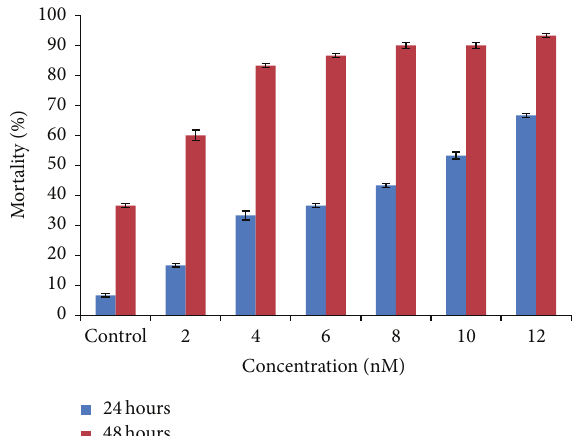
Figure 3: Bar diagram shows results for mortality rate (24 and 48 hours) of brine shrimp Artemia nauplii treated with various nanomolar concentrations of silver nanoparticles.